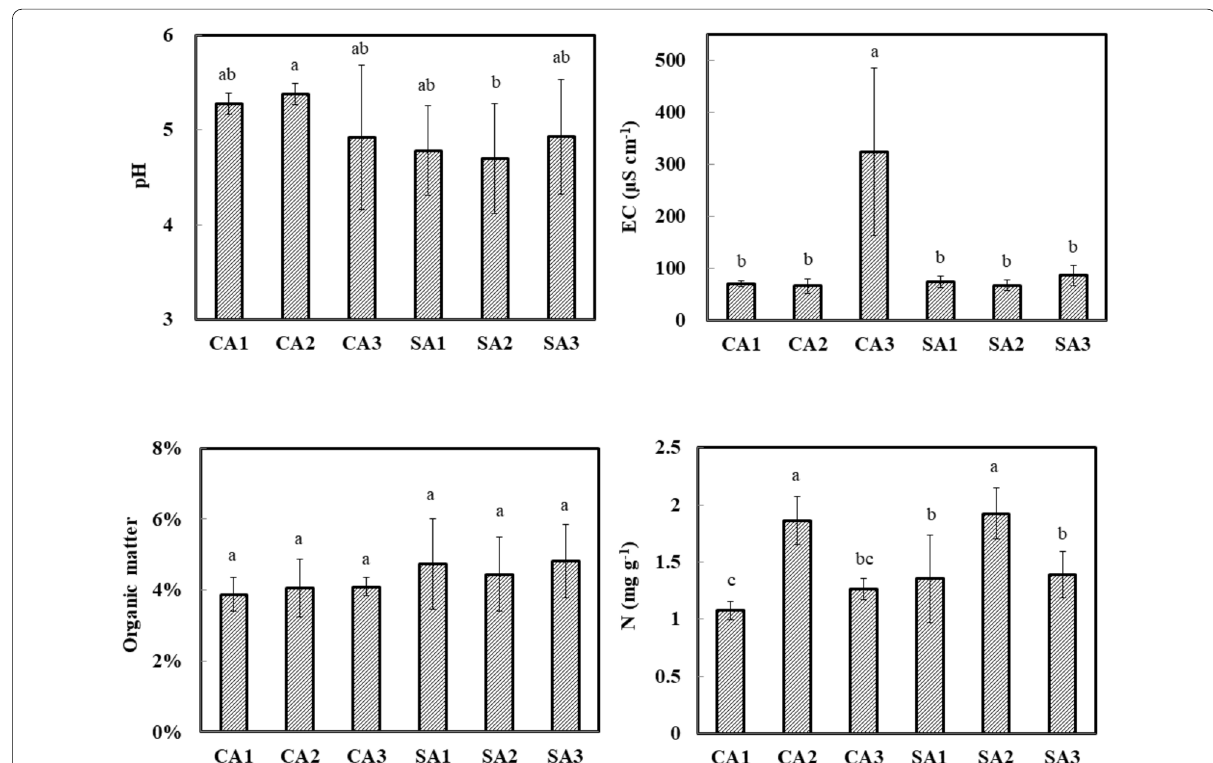
Fig. 1 Temporal variations in the soil pH, EC, total nitrogen, and organic matter of litchi orchards that were maintained under conventional (CA) and sustainable (SA) agricultural practices. 1, 2 and 3 indicate successive trimester samplings carried out on October 2016, January 2017 and April 2017, respectively. Results are shown as mean standard deviation. The different letters labeled at columns are significantly different according to ± Duncan’s test (p < 0.05) by IBM SPSS Statistics v20